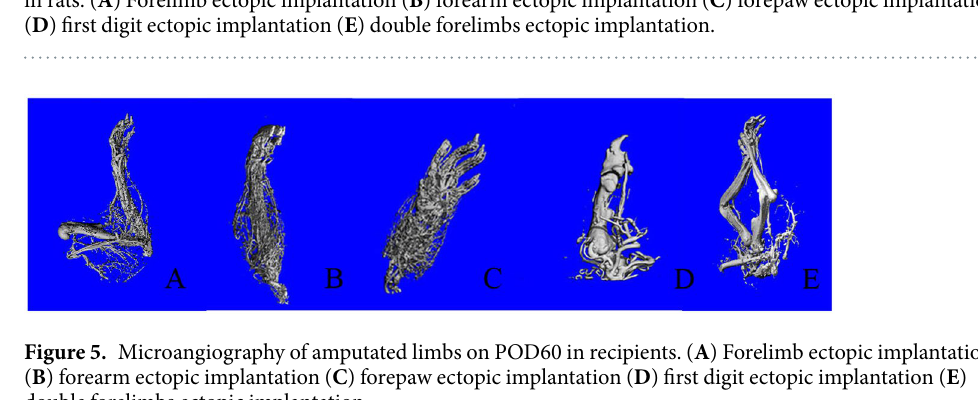
Figure 4. BPU of FLPI showed good blood supply to amputated limbs of different ectopic implantation models in rats. ( A ) Forelimb ectopic implantation ( B ) forearm ectopic implantation ( C ) forepaw ectopic implantation